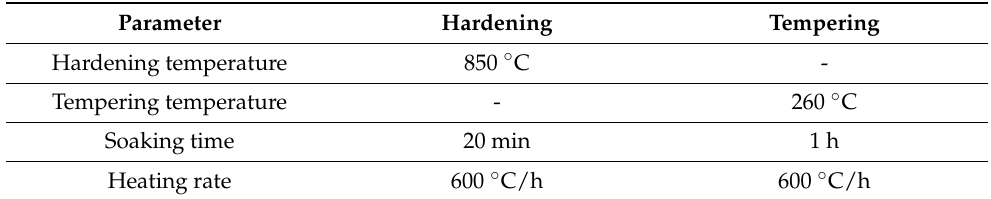
Table 1. Heat treatment parameters [22]. Parameter Hardening Tempering Hardening temperature 850 ◦ C - Tempering temperature - 260 ◦ C Soaking time 20 min 1 h Heating rate 600 ◦ C/h 600 ◦